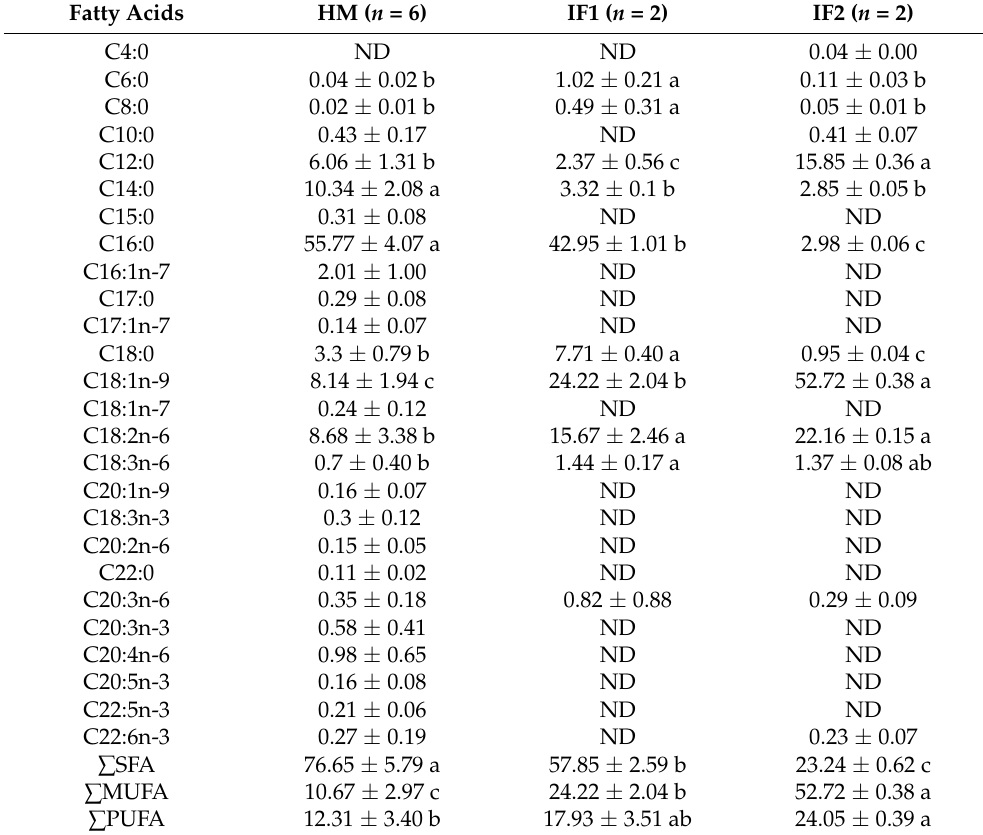
Table 3. sn -2 fatty acids composition of human milk and infant formula (%, w / w ). Fatty